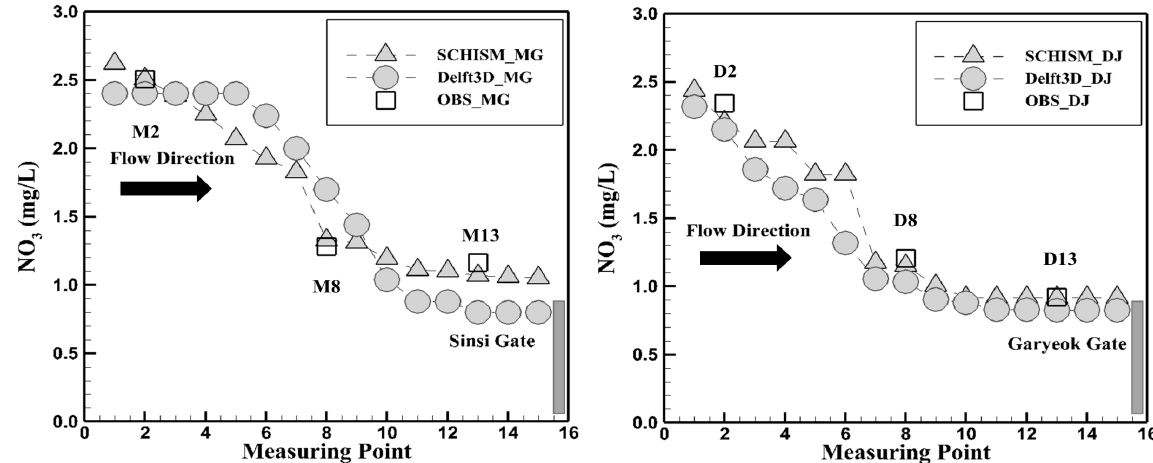
Figure 7. Comparison on the result of SCHISM-CoSiNE and Delft3D in terms of concentration about nitrate at measuring points